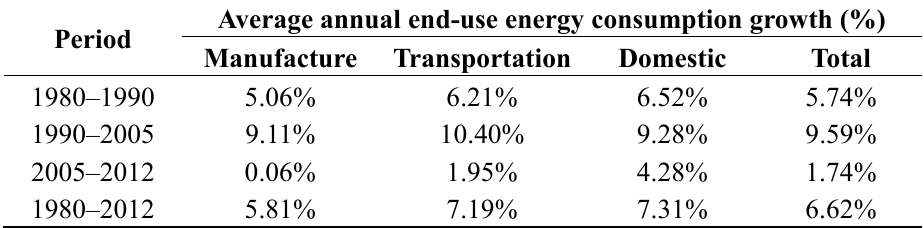
Table 7. Average annual end-use energy consumption